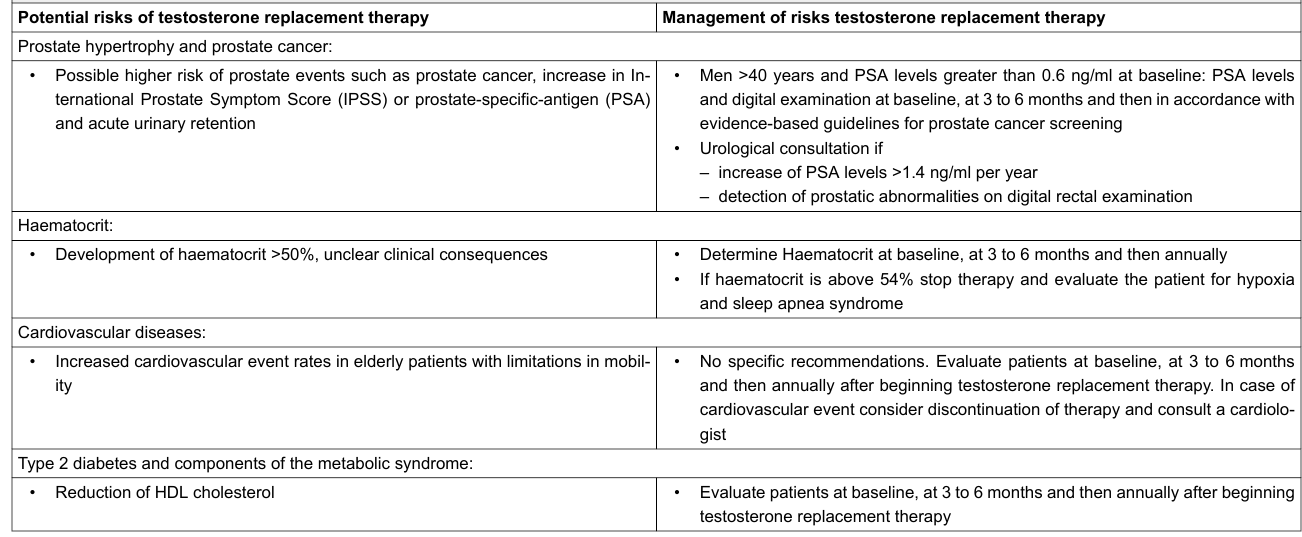
Table 2: Potential risks and management of testosterone replacement therapy in elderly men [53, 54]. Potential risks of testosterone replacement